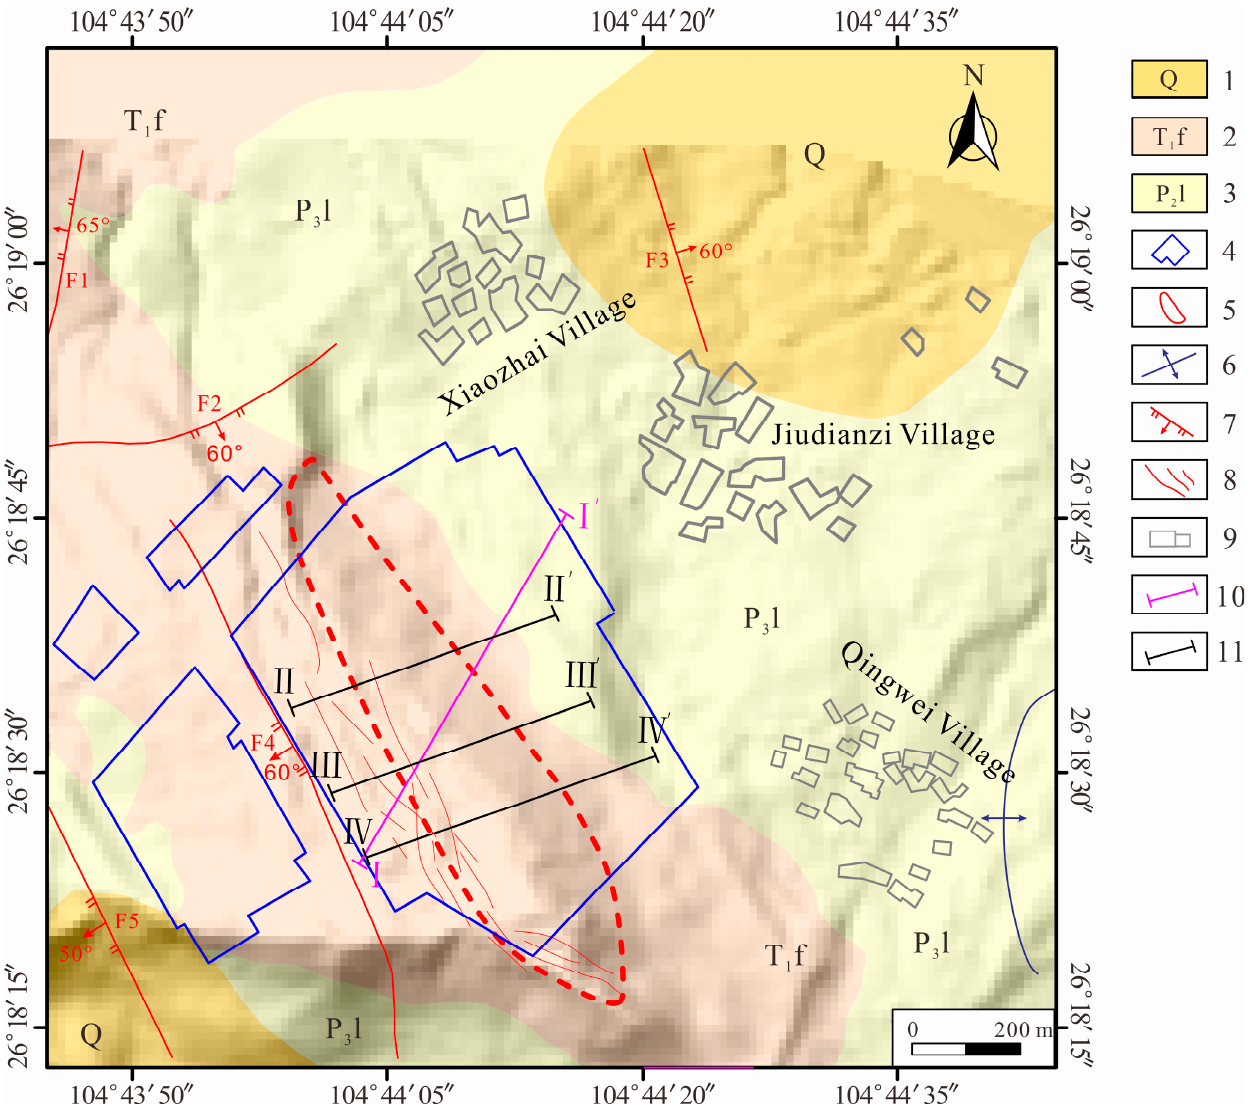
Figure 3. Engineering geological map of the study area (1. Quaternary; 2. Triassic Feixianguan Formation; 3. Permian Longtan Formation; 4. Goaf; 5. Landslide boundary; 6. Anticline; 7. Fault; 8. Surface cracks; 9. Houses; 10. Geological section line; 11. TEM ground survey line).